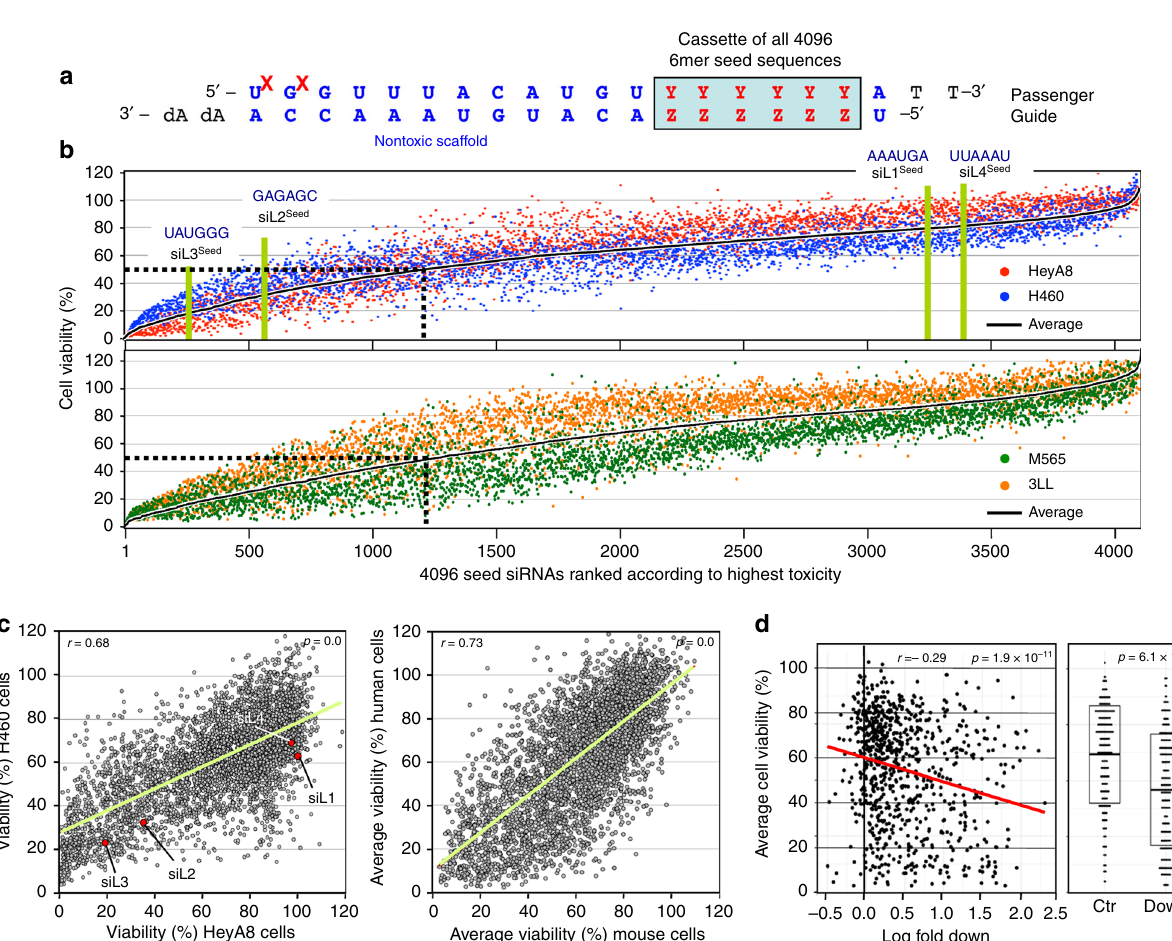
Fig. 1 A comprehensive screen identi fi es the most toxic 6mer seeds. a Schematic of the siRNA backbone used in the 4096 seed duplexes toxicity screen. Red X: 2 ′ - O -methylation modi fi cation; blue letters: constant nucleotides; red letters: variable 6mer seed sequence. b Results of the 4096 6mer seed duplex screen in two human (top) and two mouse (bottom) cell lines. Cells were reverse transfected in triplicates in 384-well plates with 10 nM of individual siRNAs. The cell viability of each 6mer seed duplex was determined by quantifying cellular ATP content 96 h after transfection. All 4096 6mer seeds are ranked by the average effect on cell viability of the four cell lines from the most toxic (left) to the least toxic (right). Rankings of the 6mer seeds of four previously characterized CD95L-derived siRNAs (siL1, siL2, siL3, and siL4) are highlighted in green. We consider an siRNA highly toxic if it reduces cell viability 90% or more and moderately toxic if it reduces cell viability 50% or more (black stippled line). c Regression analysis showing correlation between the 6mer seed toxicity observed in the human lung cancer cell line H460 ( y -axis) and the matching 6mer toxicity observed in the human ovarian cancer cell line HeyA8 ( x -axis) (left) and average toxicity in the two human cell lines ( y -axis) and two mouse cell lines ( x -axis) (right). p -Values were calculated using Pearson correlation analysis. d Left: Correlation between the log 10 (fold down underrepresentation) of all possible shRNAs that can be derived from the mRNA CDS sequence of CD95L following their expression from a DOX-inducible lentiviral vector 20 and the toxicity of their seed sequences as determined in a 4096 arrayed siRNA screen (average of both human cell lines). Right: Difference in average seed toxicity between the 137 CD95L-derived shRNAs downregulated at least fi ve-fold ( = toxic) in this screen compared to a size-matched group of 137 shRNAs that were the least altered in abundance in that screen. Pearson correlation coef fi cient is given as well as p -value (left) and p -value in analysis on the right was calculated using unpaired two-sided t -test. The center crossbar of the box plot represents the mean, and the upper/lower boundaries demark ±1 standard